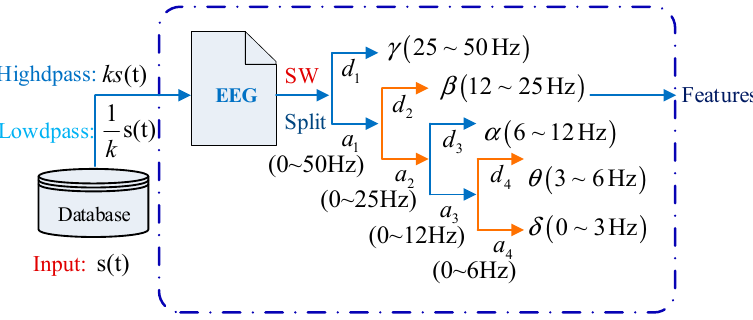
Figure 2. Frequency bands of epilepsy EEGs extracted using wavelet decomposition.